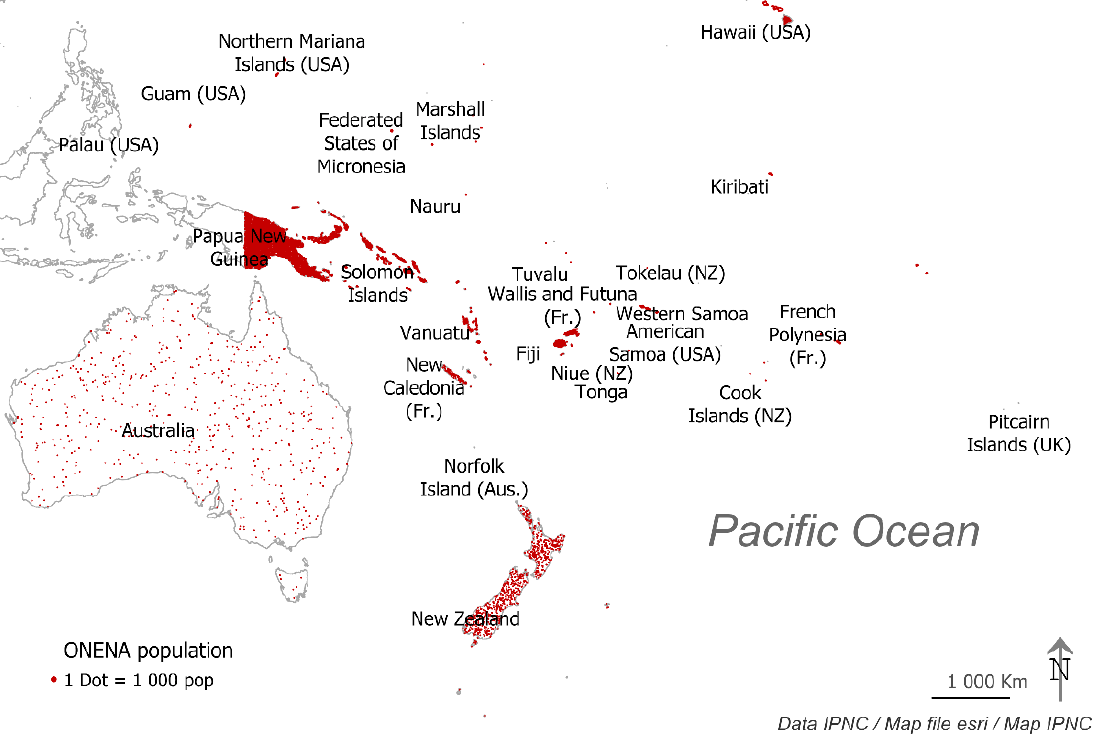
Figure 1. Oceania and relative estimates of population subgroups considered/self-declared as descending entirely or in part of Oceanian of Non-European, Non-Asian descent (ONENA) populations, Pacific region and US State of Hawaii, 2016. Points represent 1 000 pop and are randomly distributed, not georeferenced.